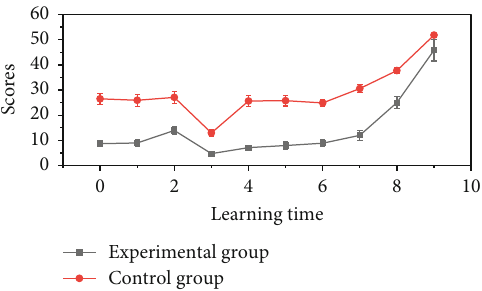
Figure 4: Descriptive statistics of the English reading posttest scores of the control class and the experimental class.